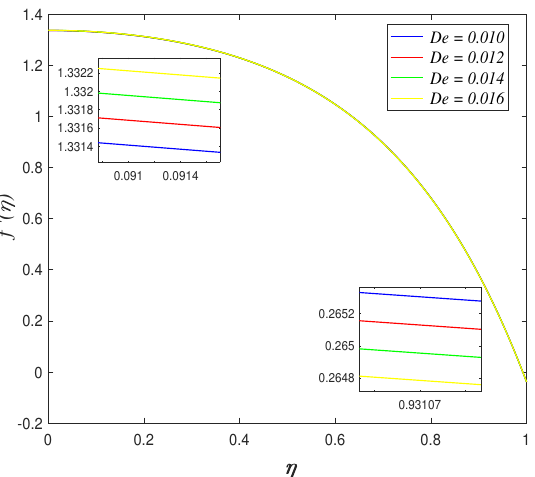
Figure 16. Impact of De on axial velocity.